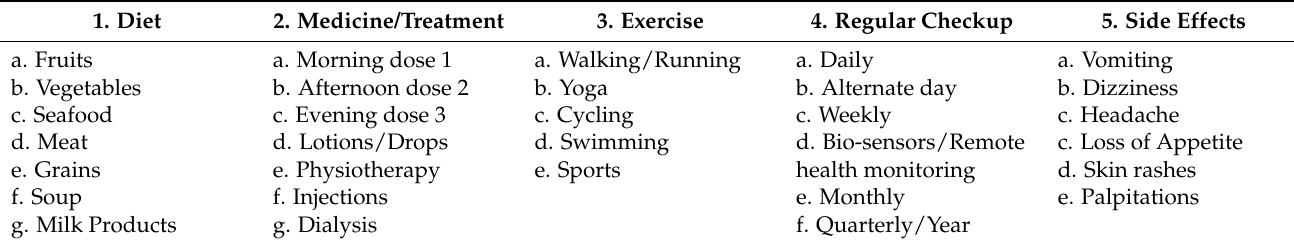
Table 7. XAI post-treatment recommendation chart.